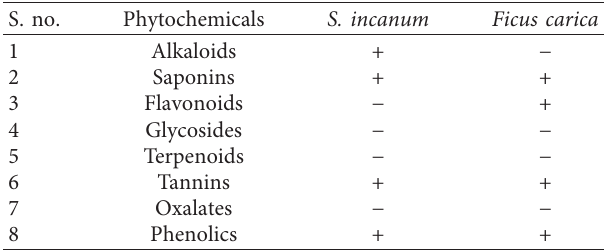
Table 4: Phytochemical screening of S. incanum and Ficus carica crude extracts.